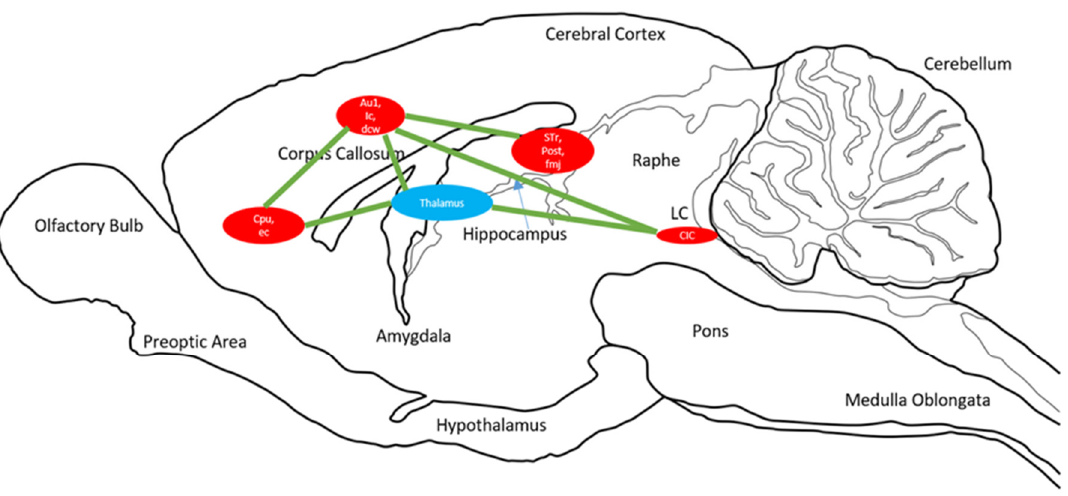
Figure 4. Sagittal drawing of overall brain circuits of brain glucose metabolism activation in response to chronic aerobic exercise. Significant clusters identified for p < 0.001, K > 50. Circle size is representative of cluster size. The blue circle is the thalamus, a relay point for many of the clusters shown in red. Green lines indicate activation circuits.